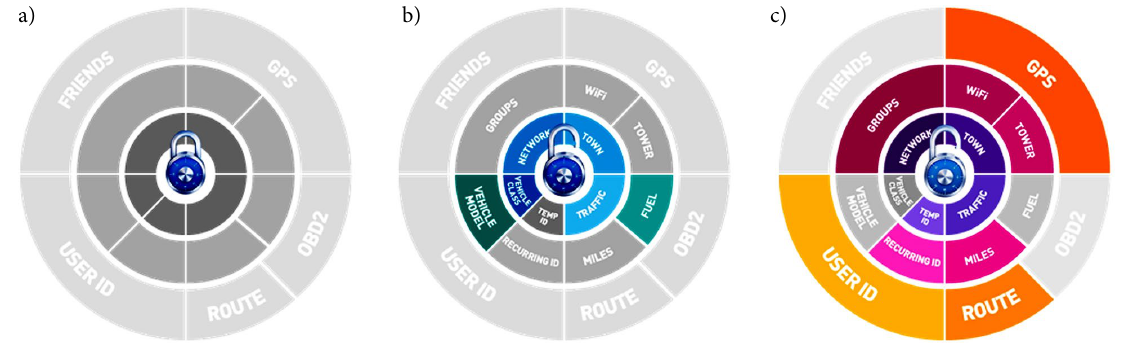
Fig. 7. Security interface for: a – an application for which a user has not released any data; b – a sample ‘cheap fuel finder’ application without navigation assistance where only some basic location information is exposed; c – a sample